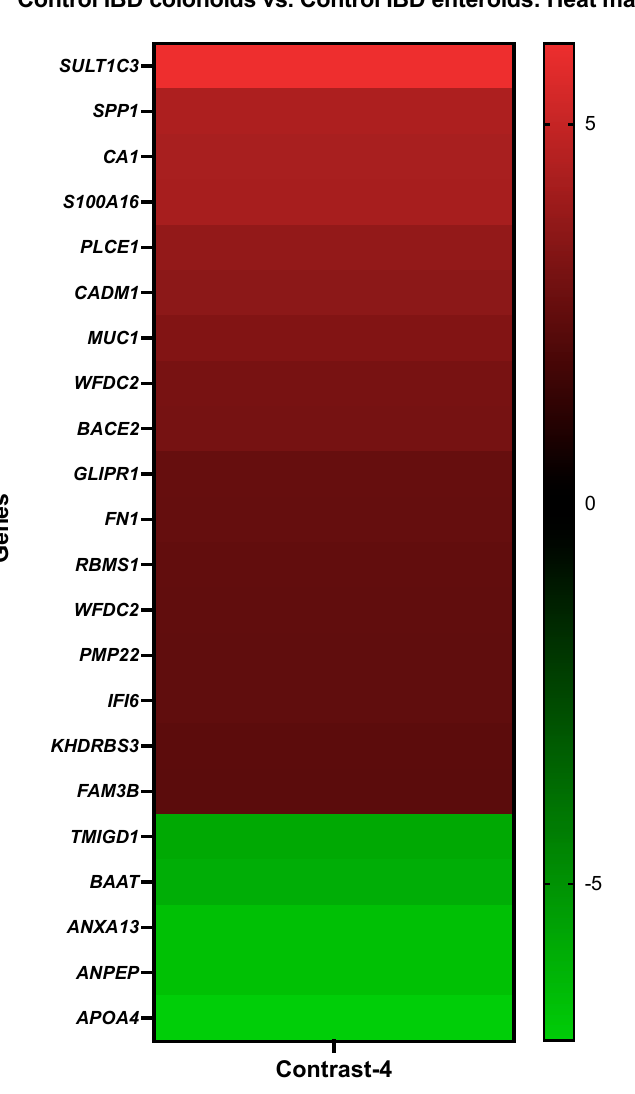
Figure 5. A heat map depicting the color-coded expression levels (log-ratio M values) of the top 17 upregulated and six downregulated DEGs in the control IBD colonoids vs. the control IBD enteroids (Contrast 4). The log-ratio M values represent the log(R/G) (log fold change) [44]. The detailed in- formation on genes is presented in Table 7. Table 7. The Gene Ontology (GO) analysis and details about the top 17 upregulated and six down- regulated DEGs in the control IBD colonoids vs. the control IBD enteroids. The DEGs annotated for biological process, molecular function, and cellular component categories are presented. The num- ber of DEGs that fell into each of these categories is shown in percentages.